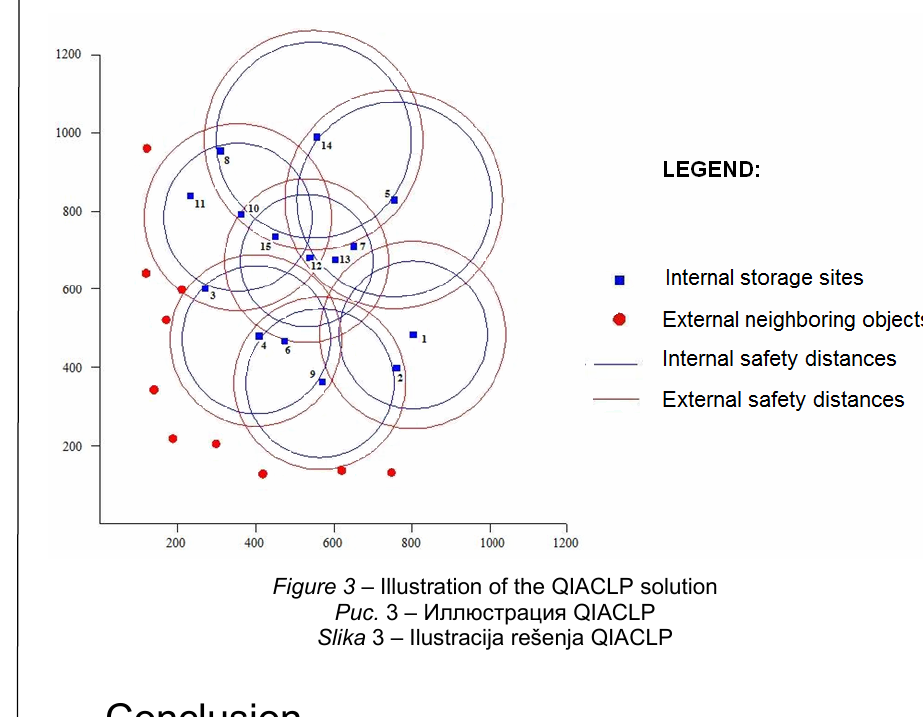
Figure 3 – Illustration of the QIACLP solution Рис . 3 – Иллюстрация